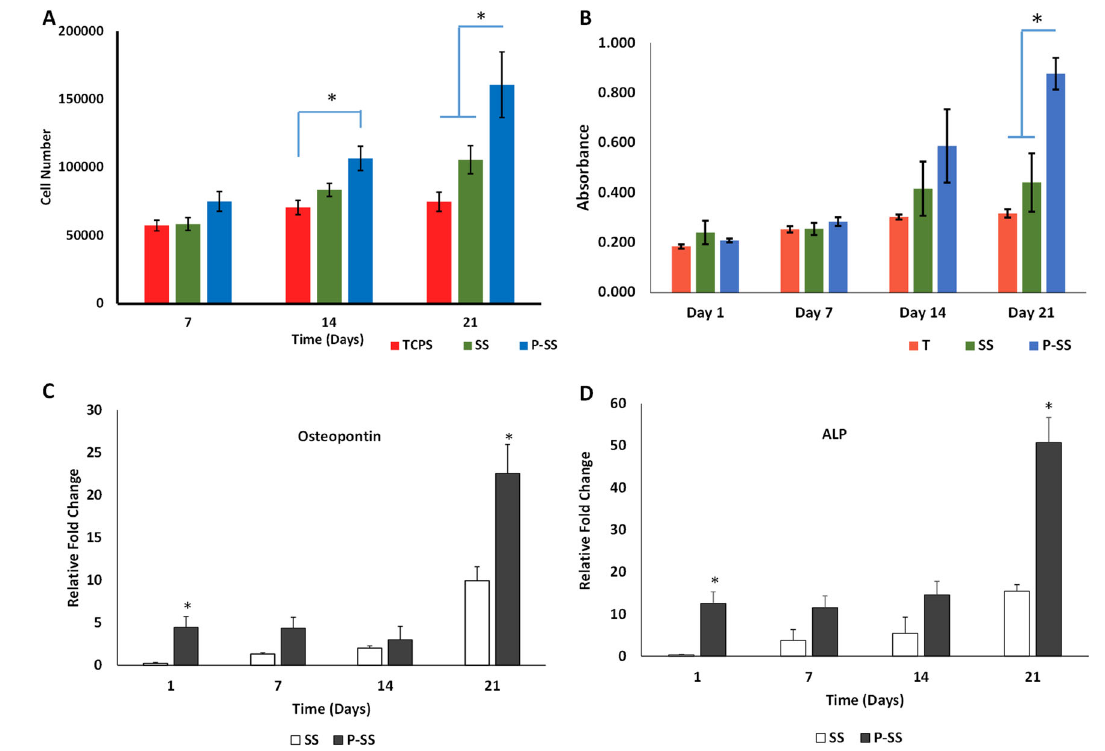
Fig. 3 A Cell proliferation assayed by DNA quanti fi cation in sintered scaffold (SS), protein-loaded SS (P-SS) and TCPS (* p < 0.05). B Alkaline Phosphatase activity of MG-63 cells cultured in sintered scaffold (SS), protein-loaded SS (P-SS) and TCPS (T); Gene